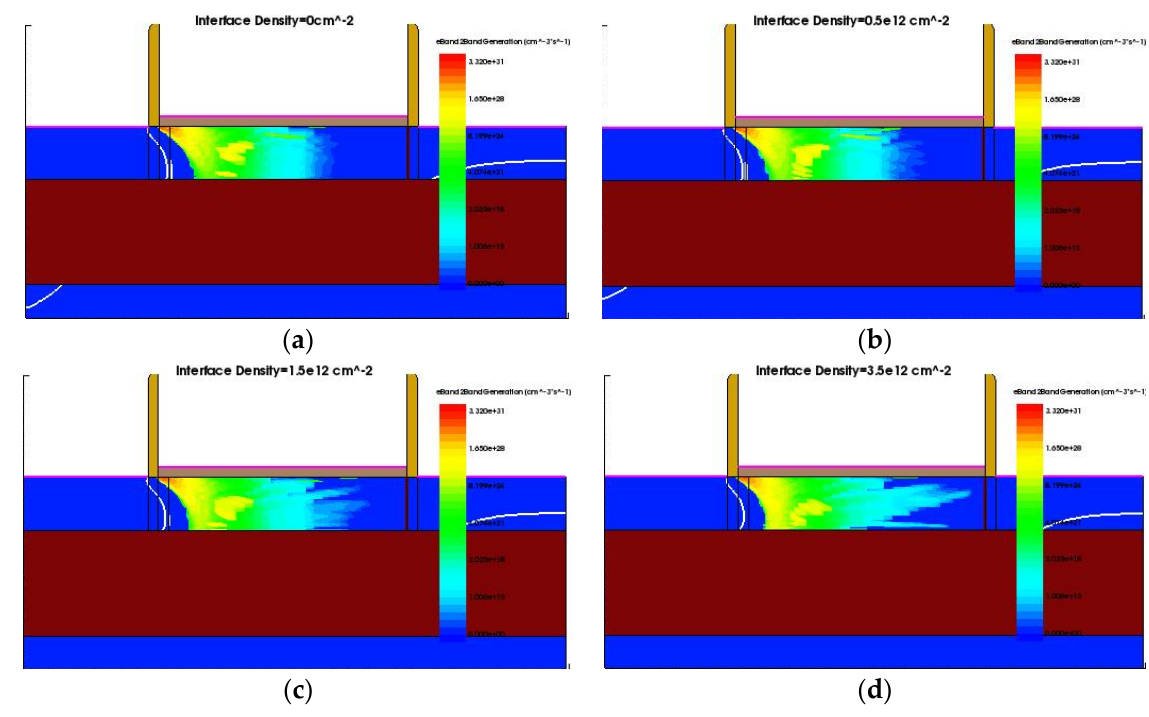
Figure 5. eBTBTGeneration profile. ( a ) Interface density = 0 cm − 2 ; ( b ) interface density = 0.5 × 10 12 cm − 2 ; ( c ) interface density = 1.5 × 10 12 cm − 2 ; ( d ) interface density = 3.5 × 10 12 cm − 2 .